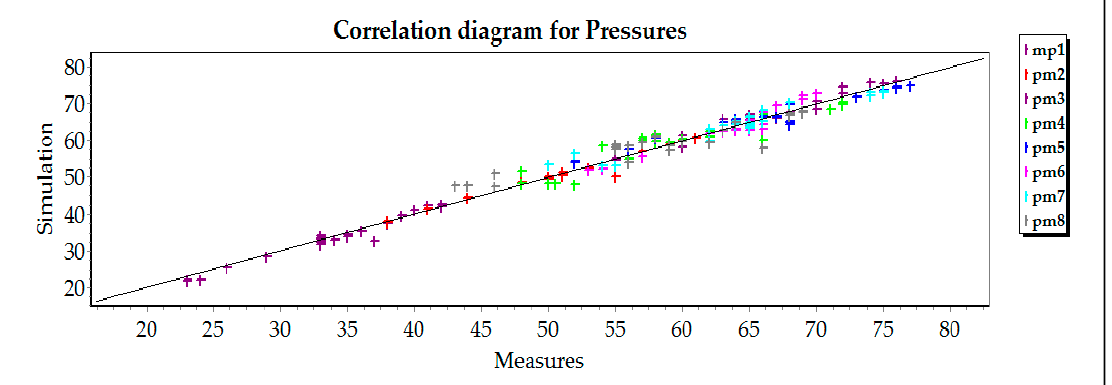
Figure 4. Pressure calibration in